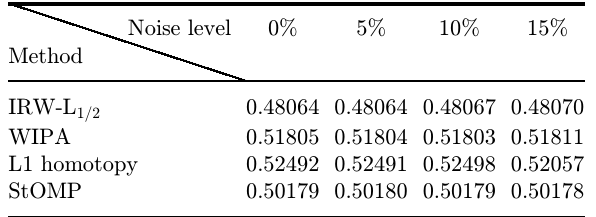
Table 2. Reconstructed location error under di®erent noise levels (mm) in single-source case.